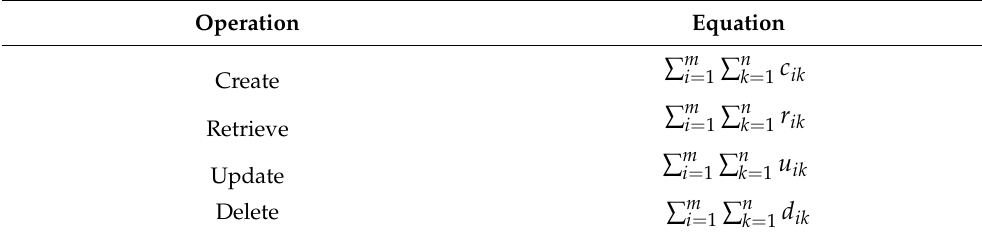
Table 5. The equations of counting records operated by four basic